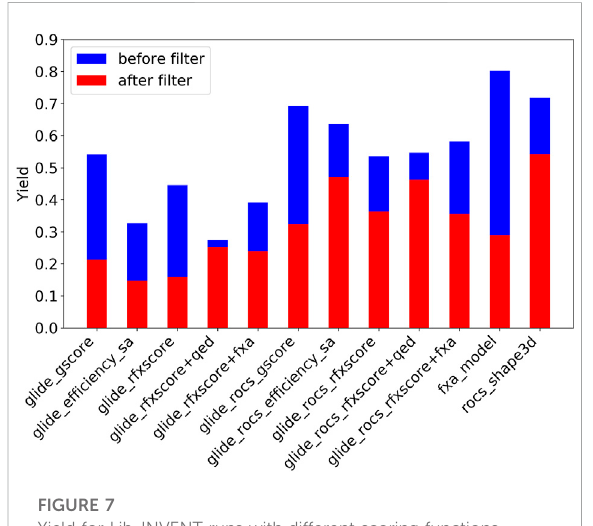
FIGURE 7 Yield for Lib-INVENT runs with different scoring functions. MedChem fi lters were applied on scaffold memory.